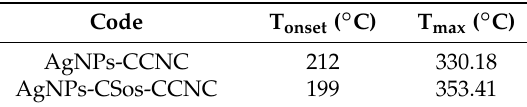
Figure 4. Thermal gravimetric analysis (TGA) curves of AgNPs-CCNC and AgNPs-CSos-CCNC; the inserts correspond to differential thermogravimetry (DTG) curves of samples. Table 1. Thermal properties results of silver nanoparticles-carboxy-cellulose nanocrystals (AgNPs-CCNC) and silver nanoparticles-chito-oligosaccharides-carboxy-cellulose nanocrystals (AgNPs-CSos-CCNC).